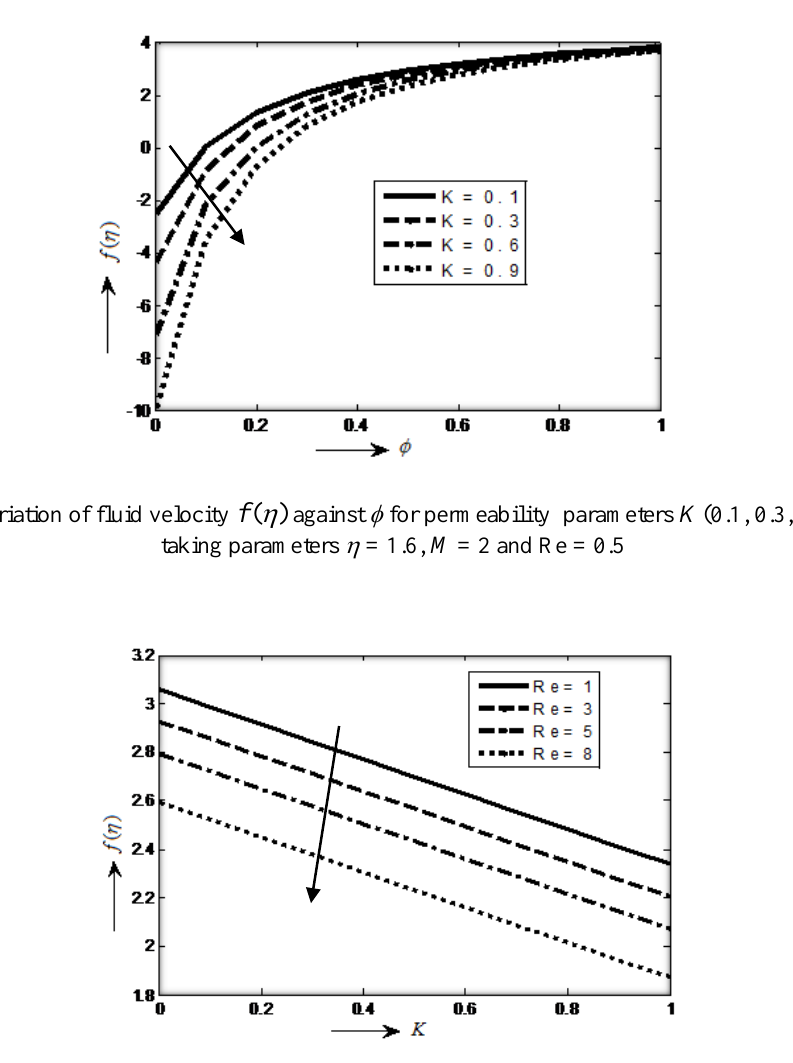
Figure 10. Variation of fluid velocity f (  ) against K for Reynolds numbers Re (1, 3, 5, 8) by taking parameters  = 1.6, M = 2 and  =